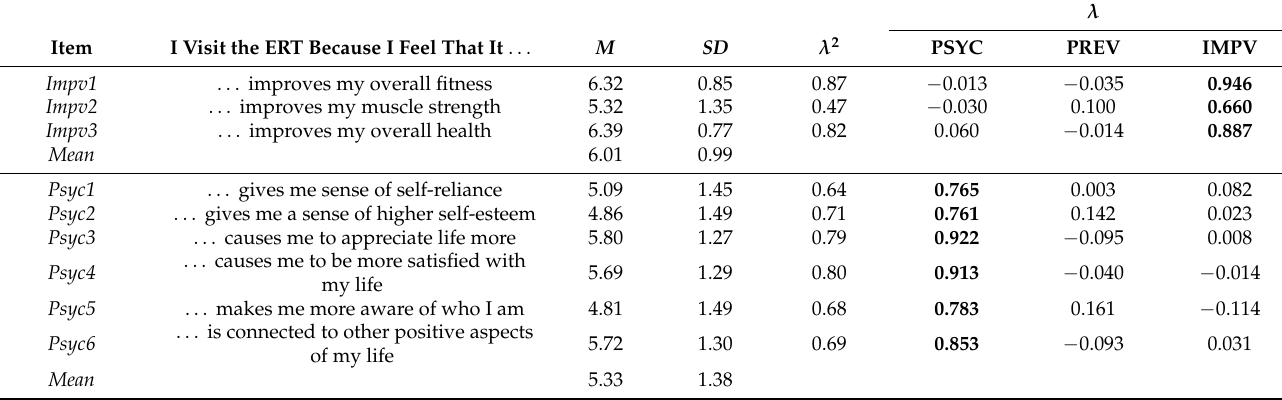
Table 2. Descriptive statistics for PHORS constructs and items with factor